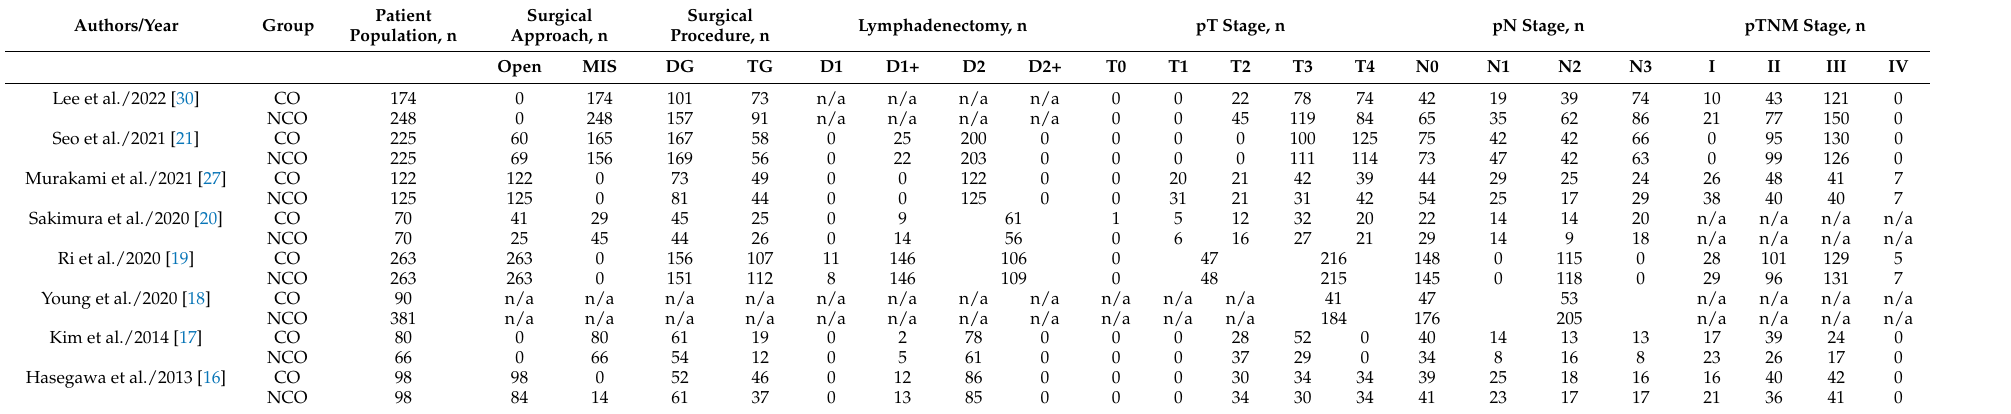
Table 2. General population